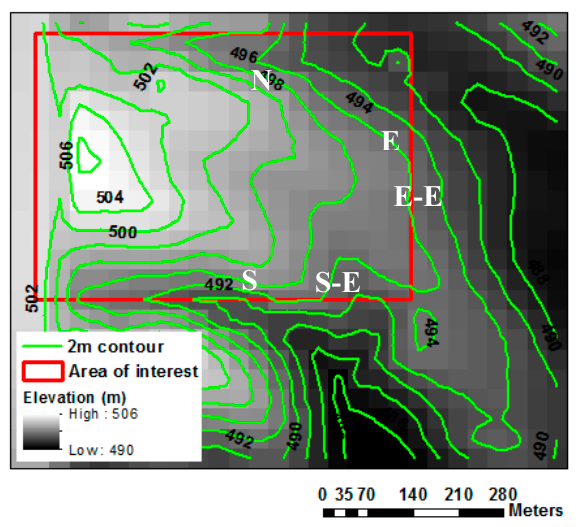
Figure 2. Elevation map of corn field with 2 m contour and area of interest (red rectangle), and five observation locations (white letters).